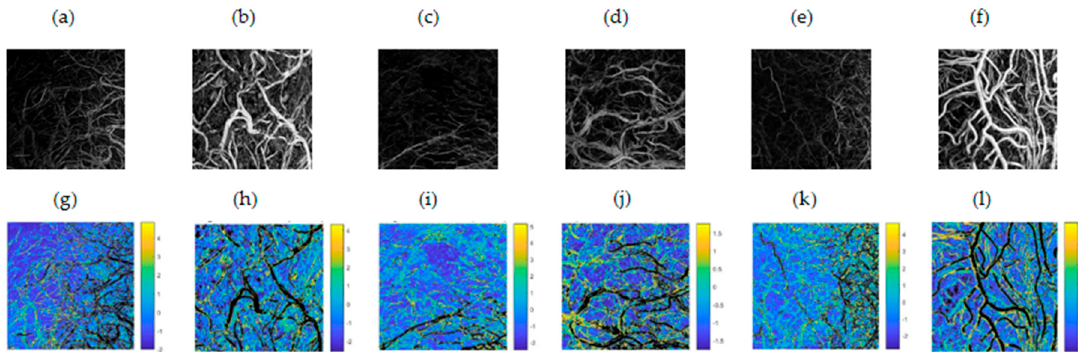
Figure 2. RGB and PCA score images of roots and soil samples representative of different cultivars and treatments, obtained from image analysis process. ( a ) RGB image of Hallertau Magnum without biochar; ( b ) RGB image of Hallertau Magnum with biochar; ( c ) RGB image of Perle without biochar; ( d ) RGB image of Perle with biochar; ( e ) RGB image of Spalter Spalt without biochar; ( f ) RGB image of Spalter Spalt with biochar; ( g ) PCA score image of Hallertau Magnum without biochar; ( h ) PCA score image of Hallertau Magnum with biochar; ( i ) PCA score image of Perle without biochar; ( j ) PCA score image of Perle with biochar; ( k ) PCA score image of Spalter Spalt without biochar; ( l ) PCA score image of Spalter Spalt with biochar.